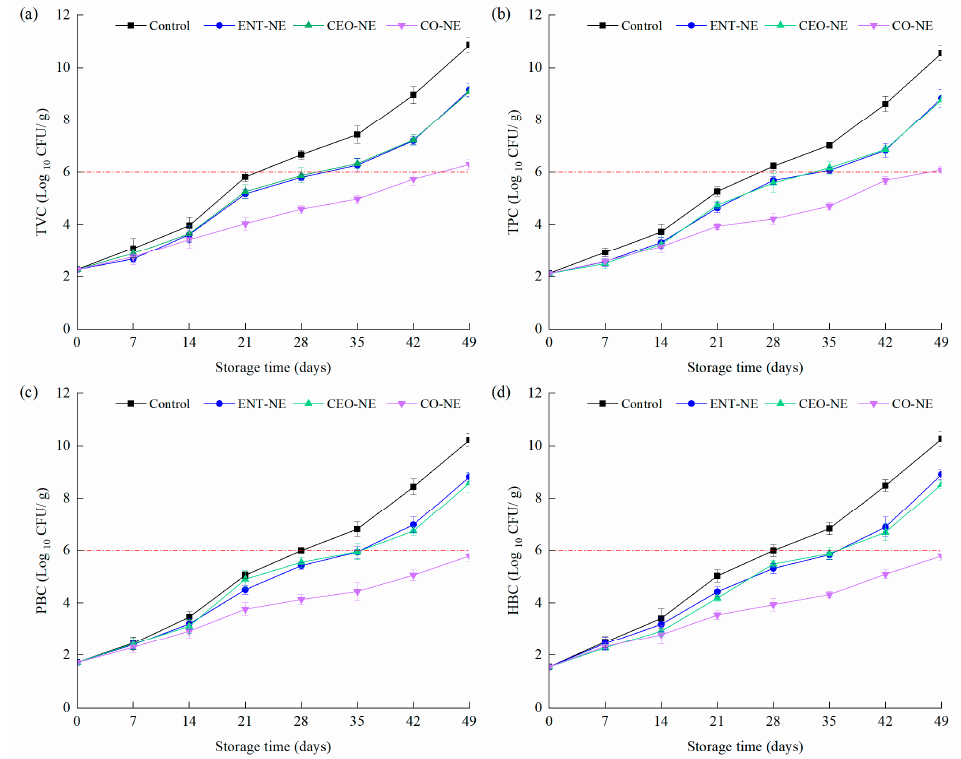
Figure 4. Changes of total viable counts (TVC) ( a ), total Pseudomonas bacteria counts (TPC) ( b ), psychrotrophic bacteria counts (PBC) ( c ) and hydrogen sulfide-producing bacteria counts (HBC) ( d ) of liquid-smoked salmon fillets treated with nanoemulsions containing enterocin Gr17 alone (ENT-NE), cinnamaldehyde alone (CEO-NE), enterocin Gr17 and cinnamaldehyde (CO-NE) and no enterocin Gr17/cinnamaldehyde (Control) during storage at 4 ◦ C for 49 days. The red dotted line means the minimal quantification